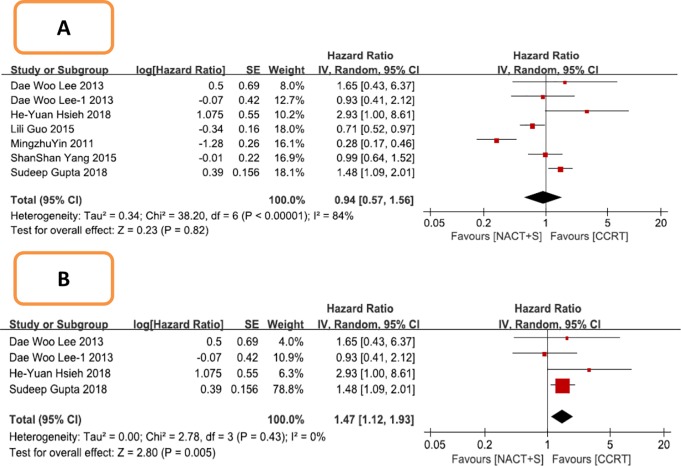
Forest plot of disease free survival (DFS) for patients with stage IB2 IIB cervical cancer.A: Including all studies; B: After excluding three Chinese studies.